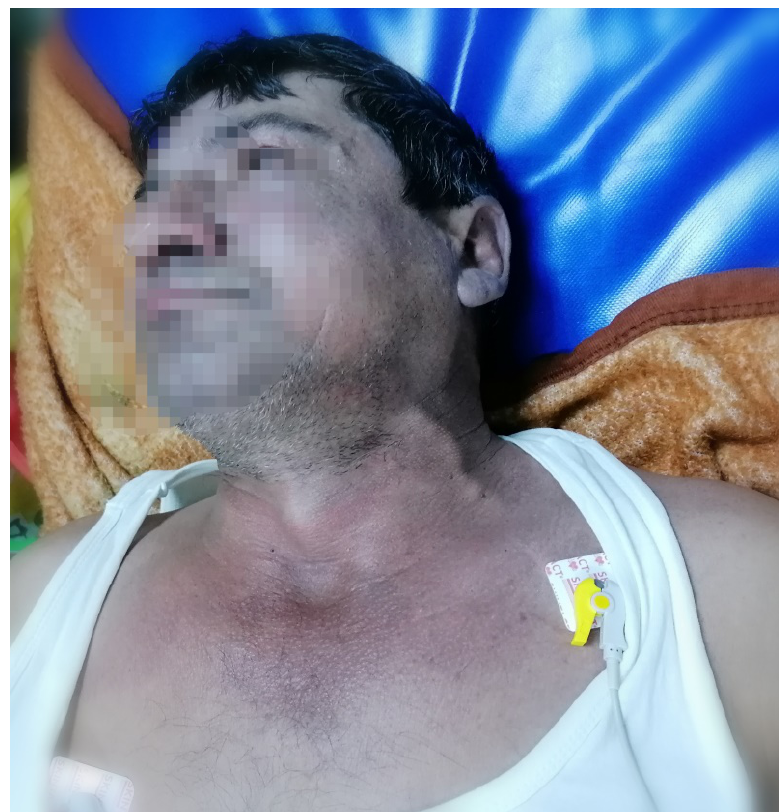
Figure 2. The patient’s turgid jugular.